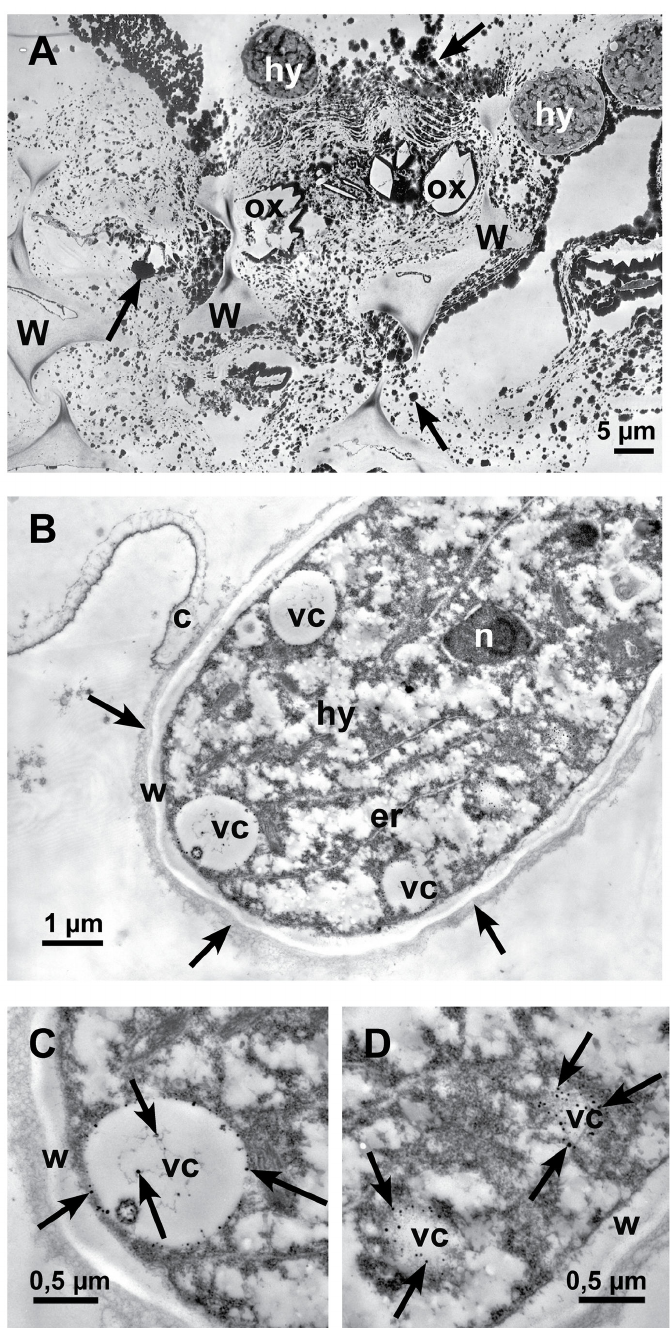
Figure 9. Localization of calcium by potassium pyroantimonate precipitation. Transmission electron micrographs of cross sections of sunflower hypocotyls. A : In the late infection stage (72 hpi), near an infection cushion, dark staining precipitates (arrows) are detectable all over in the destroyed tissue, around hyphae (hy) and oxalate crystals (ox) (crystals itself were lost during sectioning). Only residues of cell walls (w) are left. B : In the early infection stage 12-24 hpi, the longitudinal section of a hyphal tip (hy) that just penetrated the cuticle (c) is showing vesicles (vc) with small dark stained calcium precipitates. Around the cell wall of the hypha an electron dense, fibrous matrix is visible (arrows), nucleus (n), endoplasmic reticulum (er), cell wall (w) and vesicles (vc) with calcium precipitates. C : Detail of Figure 9B: Cross section of a vesicle (vc) with dark stained calcium precipitates (arrows) and cell wall (w). D : Detail of Figure 9B: Tangential section of vesicles (vc) with dark precipitates of calcium (arrows) and cell wall (w). doi: 10.1371/journal.pone.0072292.g009 PLOS ONE |